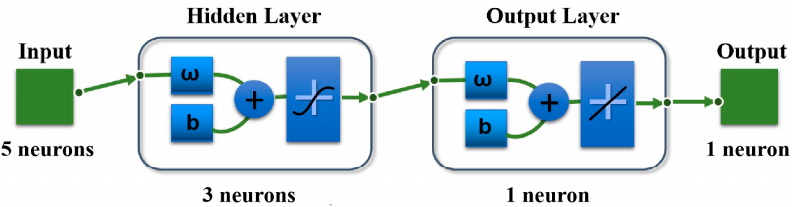
Figure 3. Establishment of